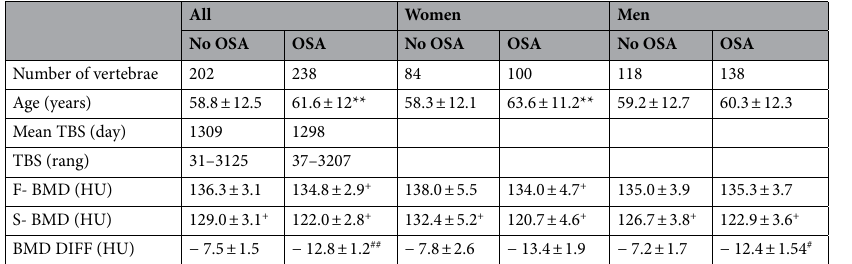
Table 3. Vertebrae bone mineral density. Bone mineral density of combined 12 thoracic (T12) and first lumbar (L1) vertebrae; Data include participants who were not administered a contrast agent; OSA obstructive sleep apnea (apnea–hypopnea index ≥ 5 events/h), TBS time duration between scans, F first scan, S second scan, DIFF difference in HU between second and first CT scans, negative sign indicates a loss in BMD, HU Hounsfield unit. Values are mean ± SD for age and SEM for the remaining parameters. # p < 0.05, ## p < 0.01 first scan vs. second scan. Statistical differences were determined by a two-tailed t-test. + p < 0.01, no-OSA vs. OSA, statistical differences were determined by a 2-way repeated measurements